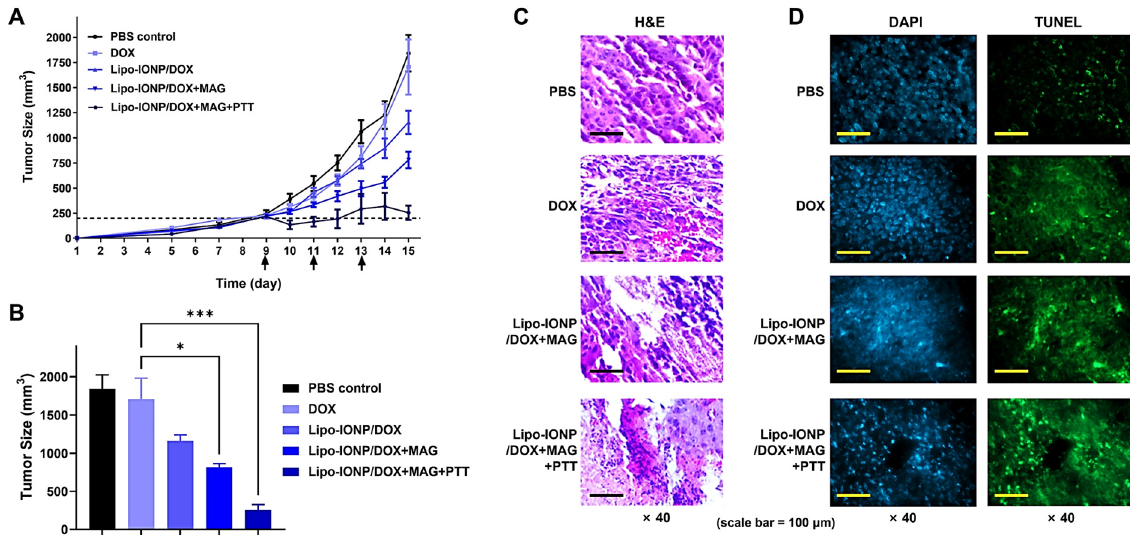
Figure 9. Efficacy study results of the combined chemo-photothermal therapy with Lipo-IONP/DOX in B16F10 s.c. allograft tumor mouse model. ( A ) Tumor size profiles along the time. ( B ) Tumor sizes at day 15 when the study was terminated. ( C ) Histological analyses of the tumor